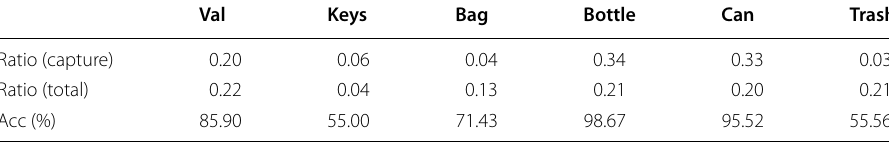
Table 1 Breakdown of prediction accuracies for each applicable item class Val Keys Bag Bottle Can Trash Ratio (capture) 0.20 0.06 0.04 0.34 0.33 0.03 Ratio (total) 0.22 0.04 0.13 0.21 0.20 0.21 Acc (%) 85.90 55.00 71.43 98.67 95.52